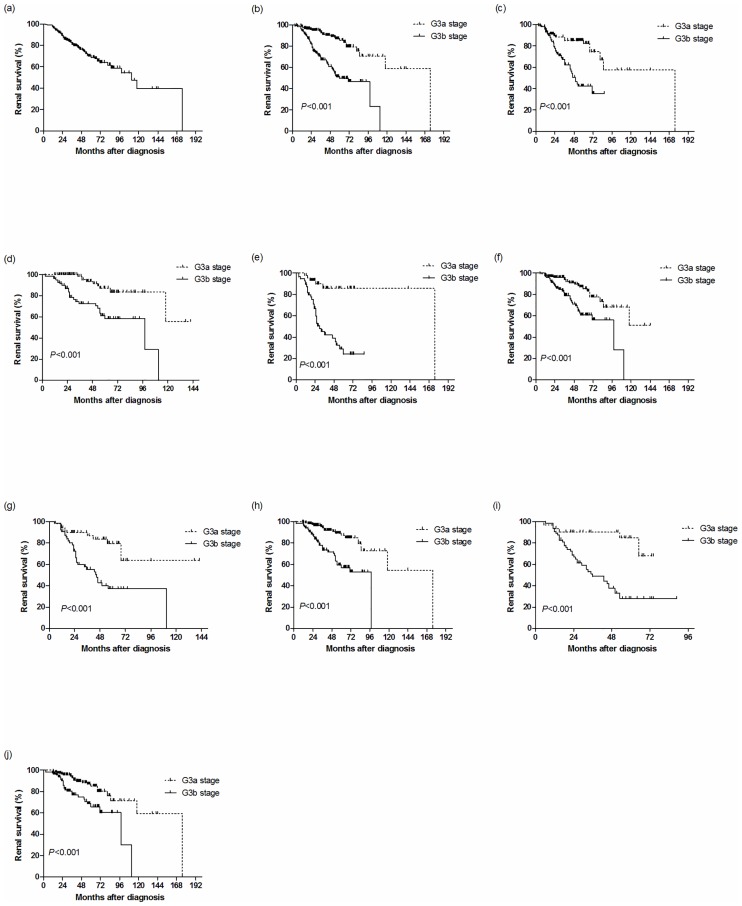
Survival curves of IgAN patients with CKD stage 3 and patients of different subgroups.(a) Patients with CKD stage 3. (b) Patients with CKD stage G3a (dotted line) or G3b (solid line) (log-rank P<0.001). Patients with G3a (dotted line) or G3b stage (solid line) based on (c) hypertension (G3a: n = 92, G3b: n = 98) (log-rank P<0.001), (d) non-hypertension (G3a: n = 117, G3b: n = 83) (log-rank P<0.001), (e) proteinuria ≥3.5 g/d (G3a: n = 48, G3b: n = 56) (log-rank P<0.001), (f) proteinuria< 3.5 g/d (G3a: n = 161, G3b: n = 125) (log-rank P<0.001), (g) anemia (G3a: n = 51, G3b: n = 64) (log-rank P<0.001), (h) non-anemia (G3a: n = 158, G3b: n = 117) (log-rank P<0.001), (i) serum phosphorus ≥1.45 mmol/L (G3a: n = 33, G3b: n = 67) (log-rank P<0.001), (j) serum phosphorus <1.45 mmol/L (G3a: n = 176, G3b: n = 114) (log-rank P<0.001). Abbreviations: IgAN, IgA nephropathy; CKD, chronic kidney disease.